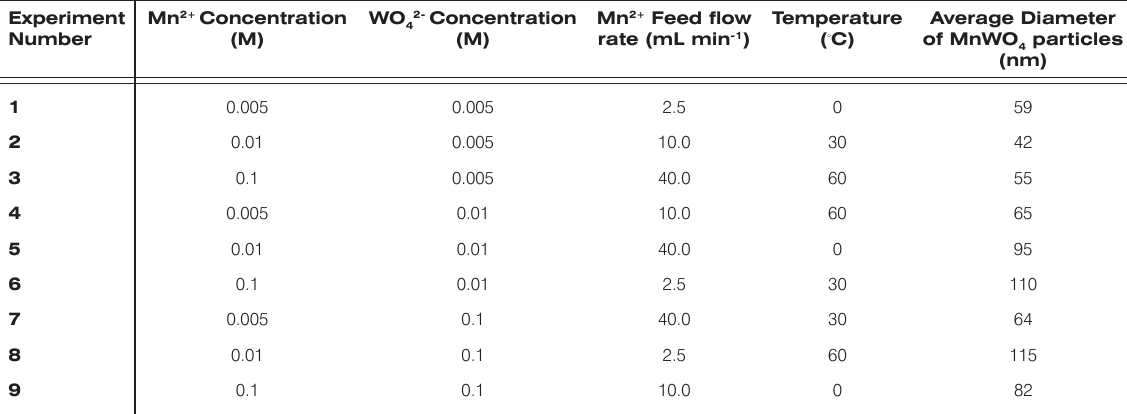
Table 1. OA (3 4 ) matrix for parameter optimization in synthesis of nanoplates via direct precipitation reaction and mean diameter of produced 9 manganese tungstate. Experiment